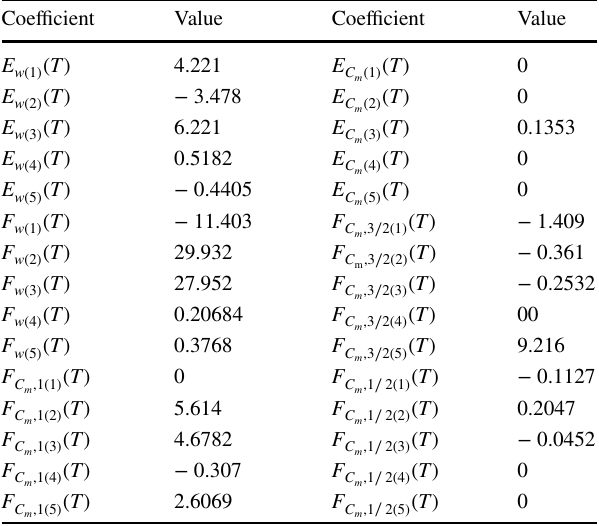
Table 7 Values of constant coefficients in brine compressibility equa- tion (Eq. (16))